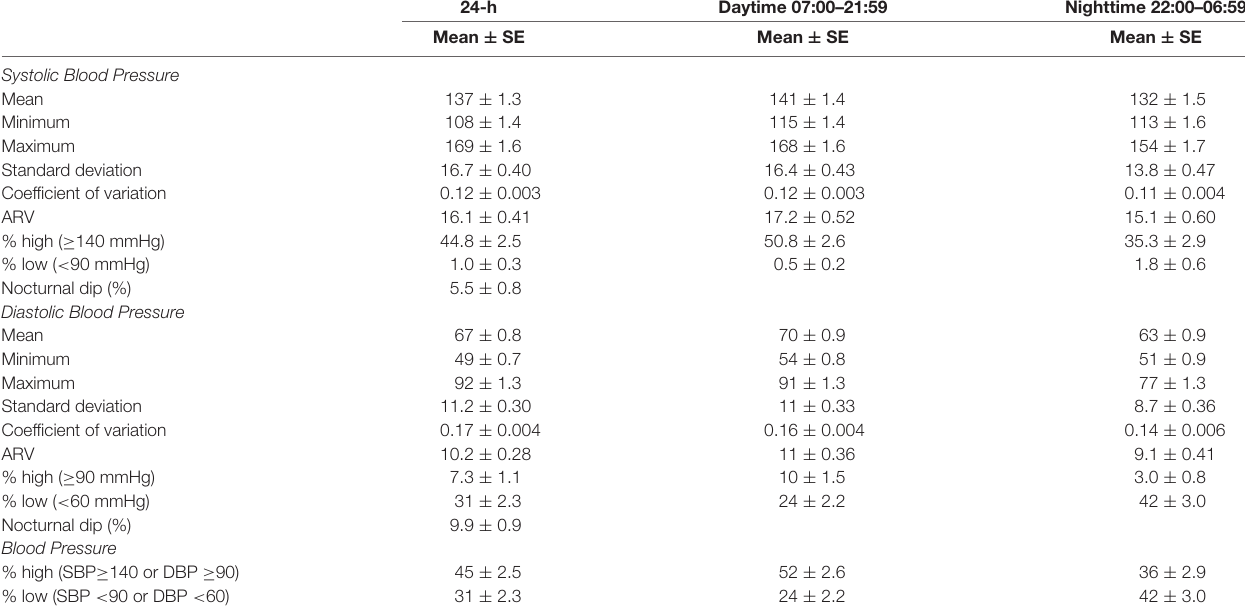
TABLE 2 | Twenty-four hour BP levels and variability measurements in 121 subjects.